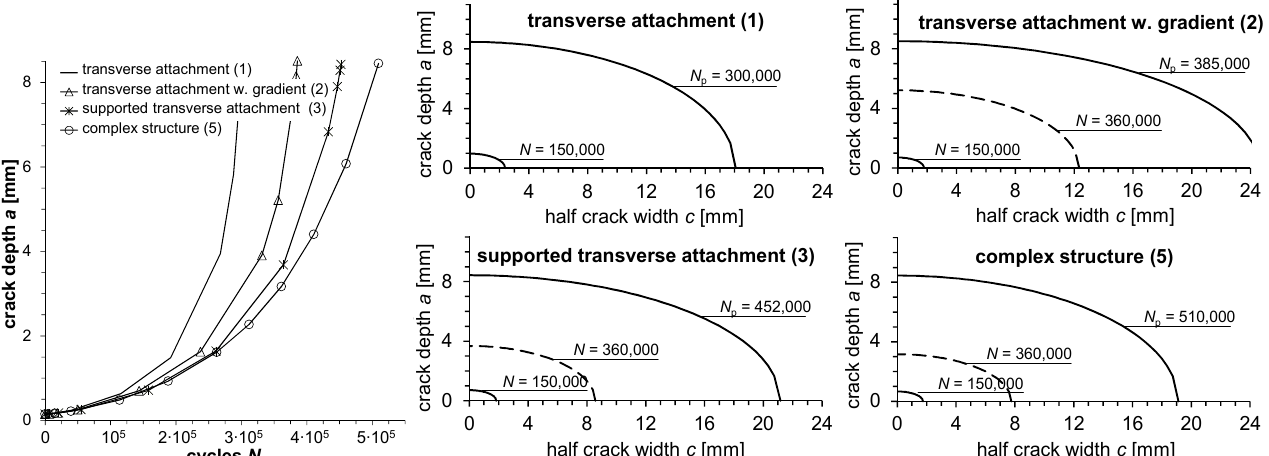
Figure 3: Determined crack depth vs. Figure 4: Calculated crack shapes for variants 1 to 3 and 5.